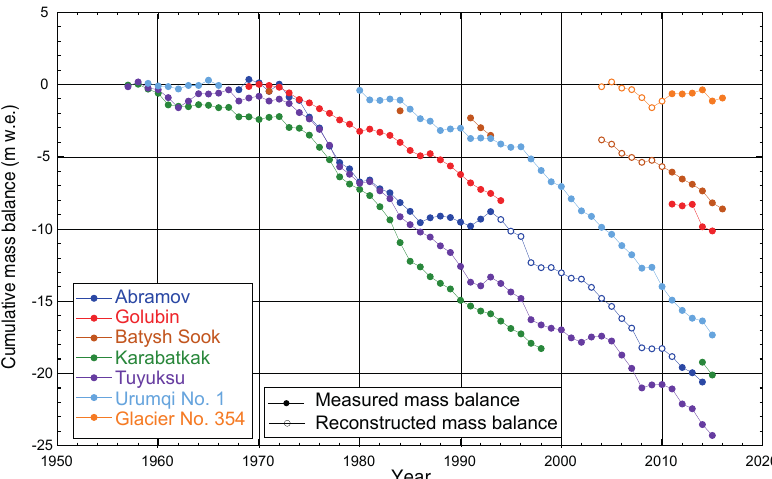
Figure 6. Cumulative mass balance measurements for glaciers in Central Asia. Filled dots are direct glaciological measurements, and non- filled dots are reconstructed values.